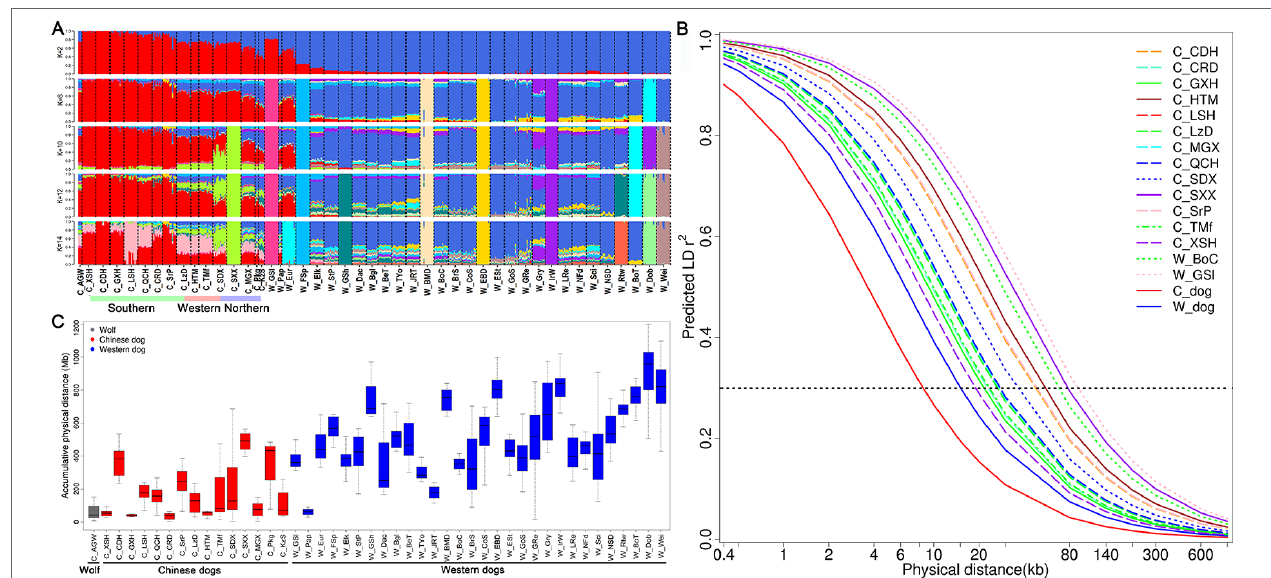
FIGURe 3 | Admixture, runs of homozygosity, and genome-wide linkage disequilibrium (LD) of Chinese dogs compared with Western dogs. (a) Admixture analysis in Chinese indigenous dog populations compared with Western dogs (from K = 2 to K = 6). Red bars represent Chinese dog breeds and blue bars indicate Western dog breeds (K = 2). (B) Decline in genome-wide linkage disequilibrium (predicted r 2 ) across and within breeds. (C) Accumulative physical length of runs of homozygosity (ROH) in Chinese and Western dog